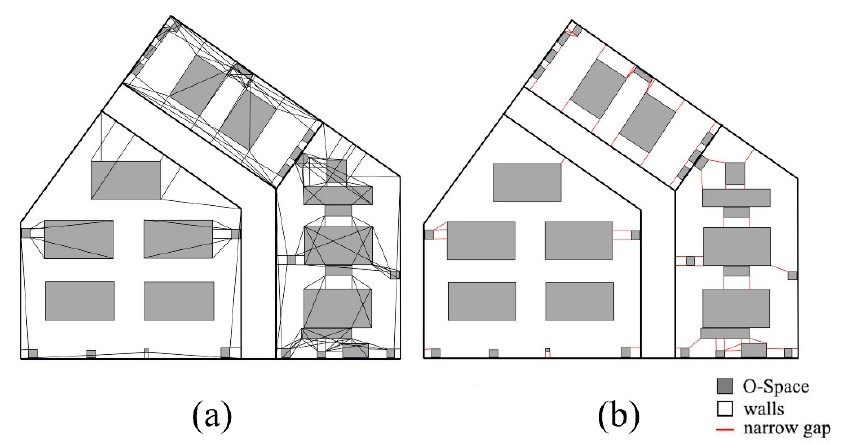
Figure 15. The generation of narrow gaps for a disabled adult male. ( a ) The MDs between each 𝐼𝑂 and every 𝐼𝑂 in its buffer. ( b ) The narrow gaps of the experimental environment.